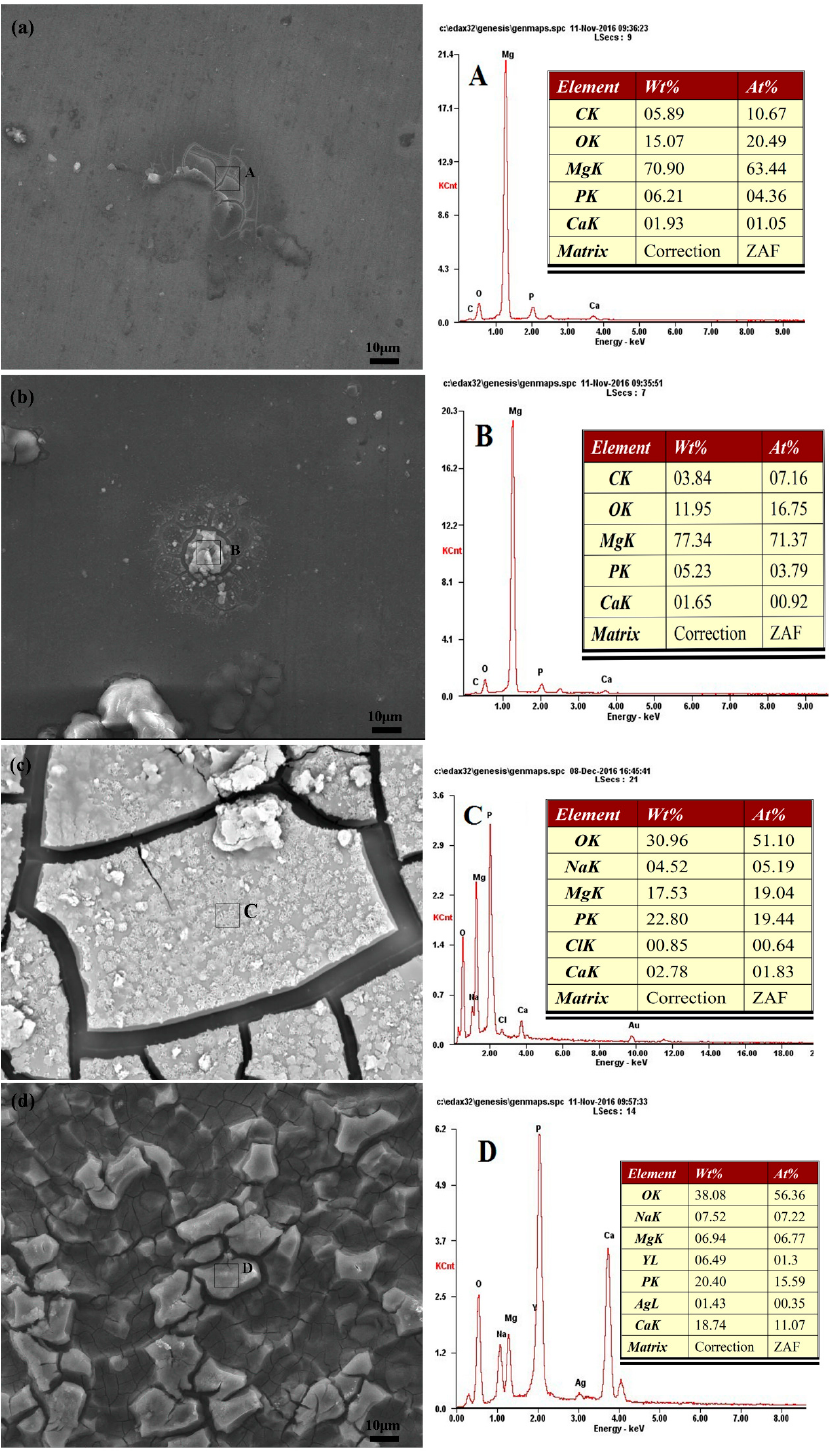
Figure 4. Surface morphologies and EDS analysis of the Ex-Mg and Ex-Mg-4Y-1Ag alloy exposed to PBS solution at 37 ◦ C for different degradation times: ( a ) Ex-Mg at 24 h; ( b ) Ex-Mg-4Y-1Ag at 24 h; ( c ) Ex-Mg at 120 h; and ( d ) Ex-Mg-4Y-1Ag at 120 h. EDS in Zone ( A ) for Figure 4a; Zone ( B ) for Figure 4b; Zone ( C ) for Figure 4c; and Zone ( D ) for Figure